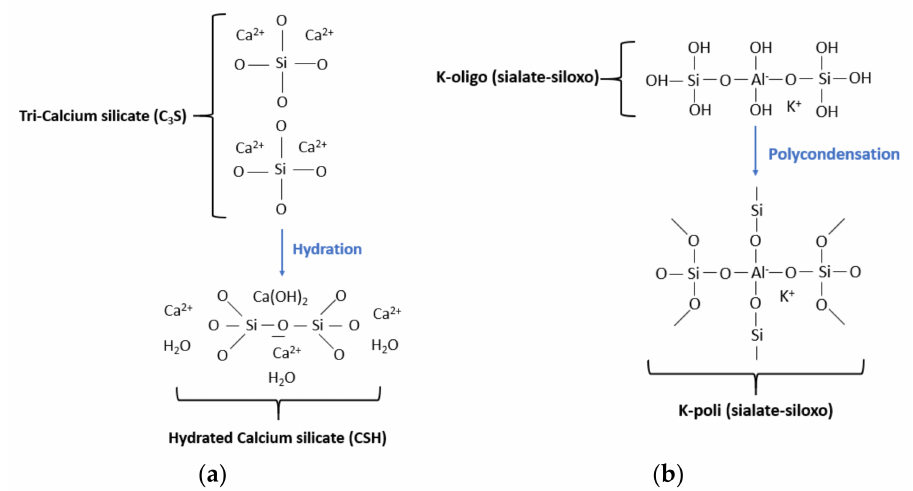
Figure 13. Hardening mechanism in PC ( a ) and geopolymer cement ( b ) [37].